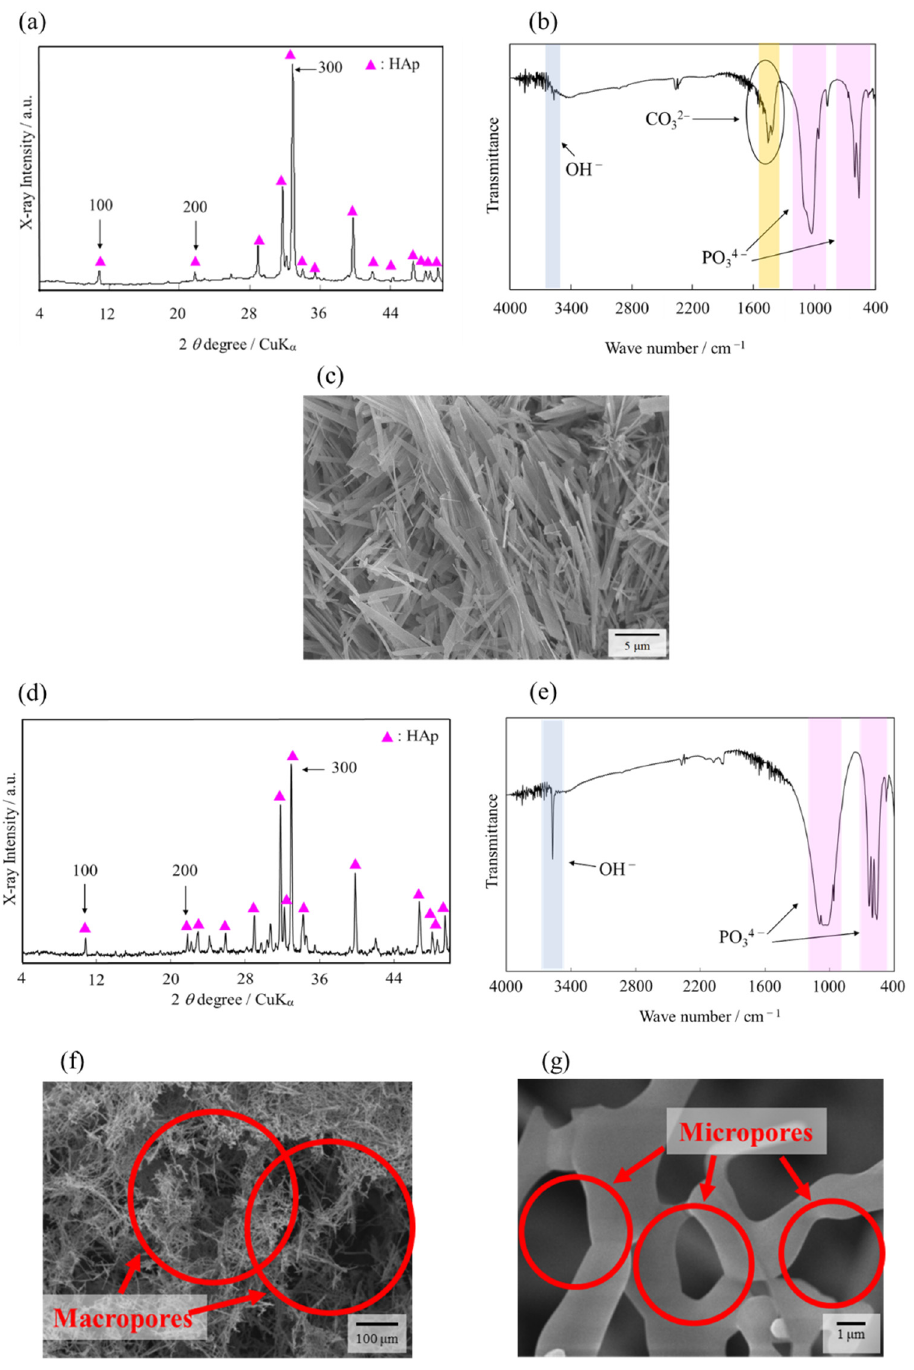
Figure 1. Characterization of AFs and AFS2000. ( a ) XRD pattern, ( b ) FT-IR spectra, ( c ) morphology of AFs, ( d ) XRD pattern, ( e ) FT-IR spectra, and ( f ) microstructure of AFS2000 at low and ( g ) high magnifications. The vertical axis in Figure 1a,d is shown as an arbitrary unit (a.u.).